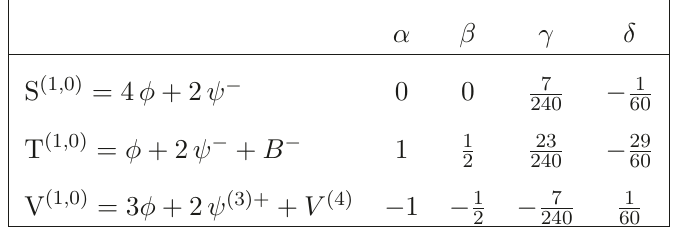
Table 8 . Anomaly coefficients of (1 , 0) superconformal multiplets in six